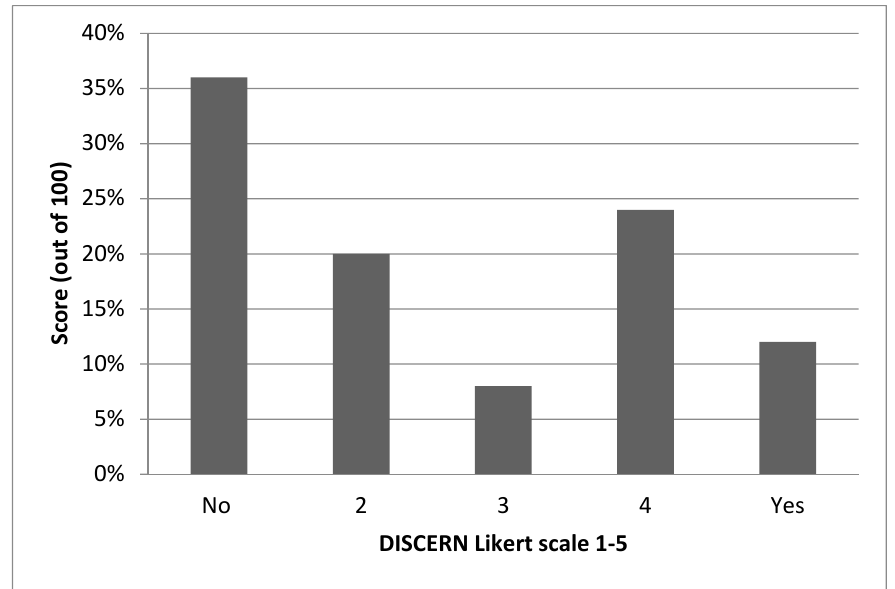
Figure 2. Clarity of sources of all included websites by HPs. Appl. Sci. 2020 , 10 , x FOR PEER REVIEW